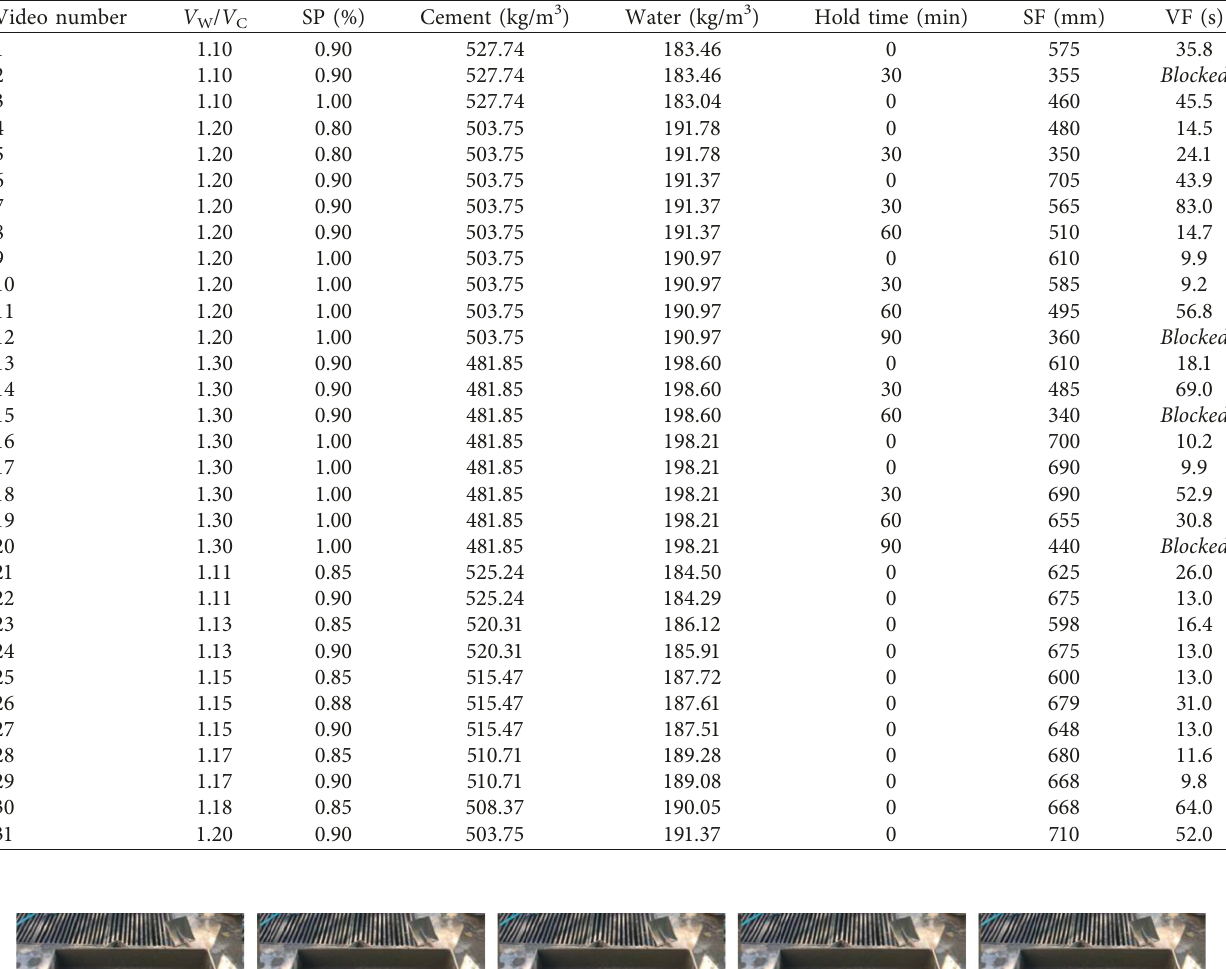
Table 1: Mix composition and workability characteristics of mixing videos.